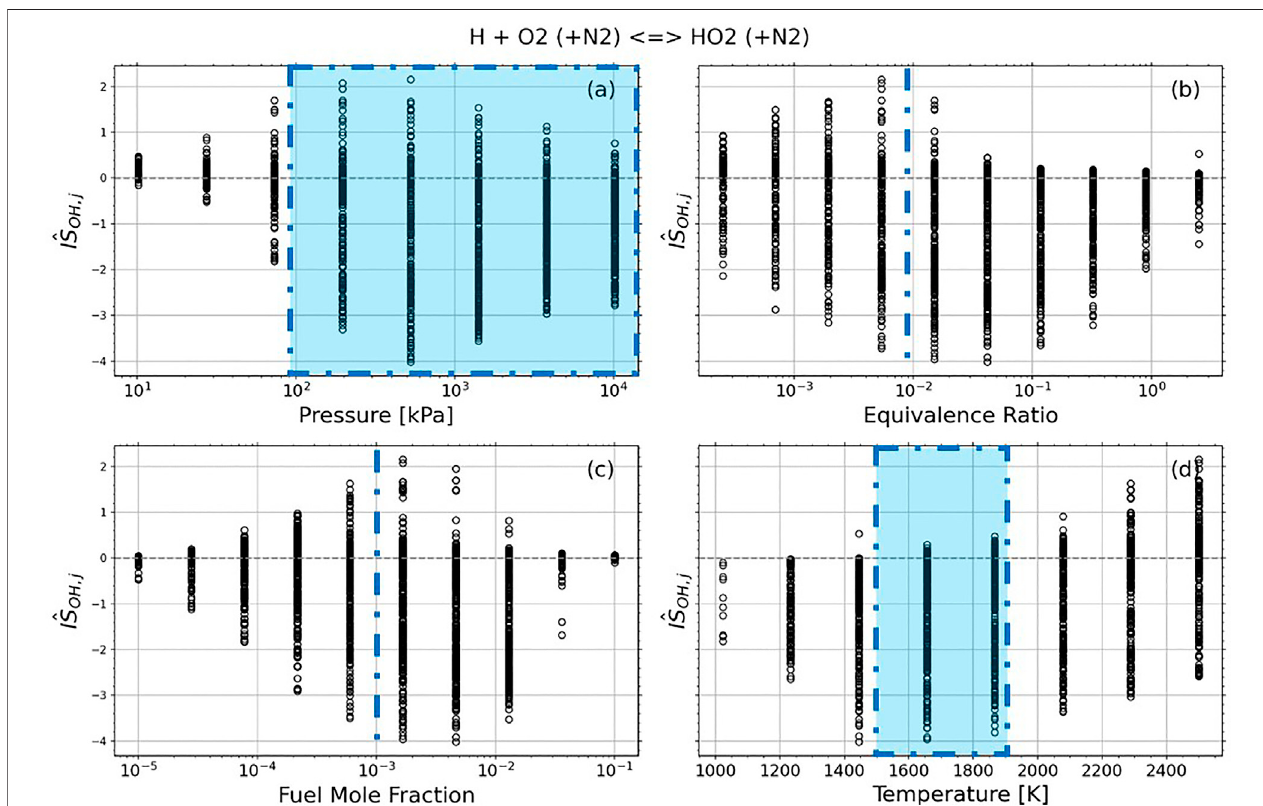
FIGURE3| Trendsinnormalizedintegratedstrengthforthereactionofinterest.ThebluedashedlinesandregionsrepresentconditionsofChoudharyetal.(2019).